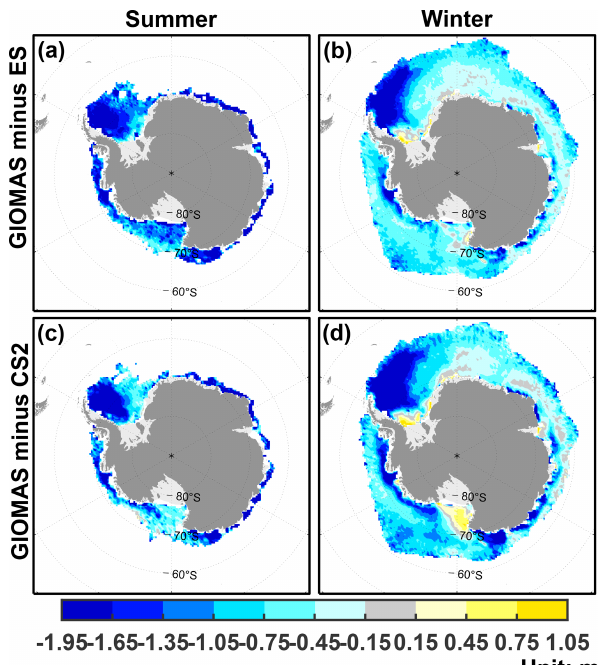
Figure 4. The SIT bias of GIOMAS relative to ES in (a) summer and (b) winter. (c) – (d) Same as (a) – (b) but for bias relative to